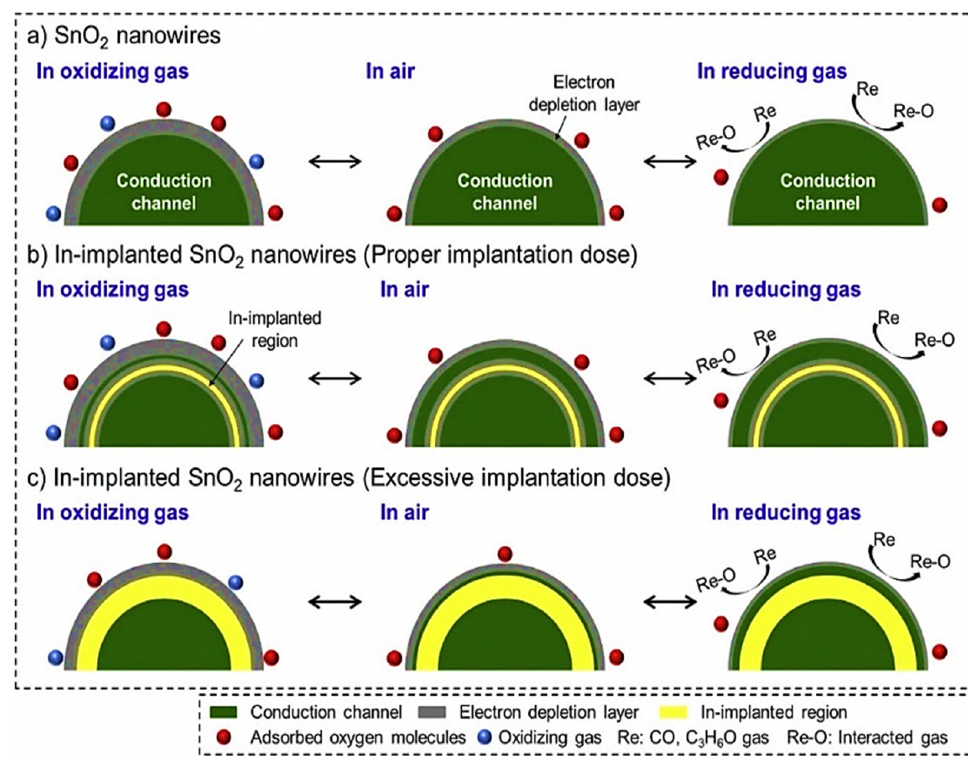
Figure 28. Schematic of the gas-sensing mechanisms of ( a ) SnO 2 NWs without implantation and In- implanted SnO 2 NWs with ( b ) optimal and ( c ) excessive implantation doses. Reproduced from [136] with the permission of Elsevier.